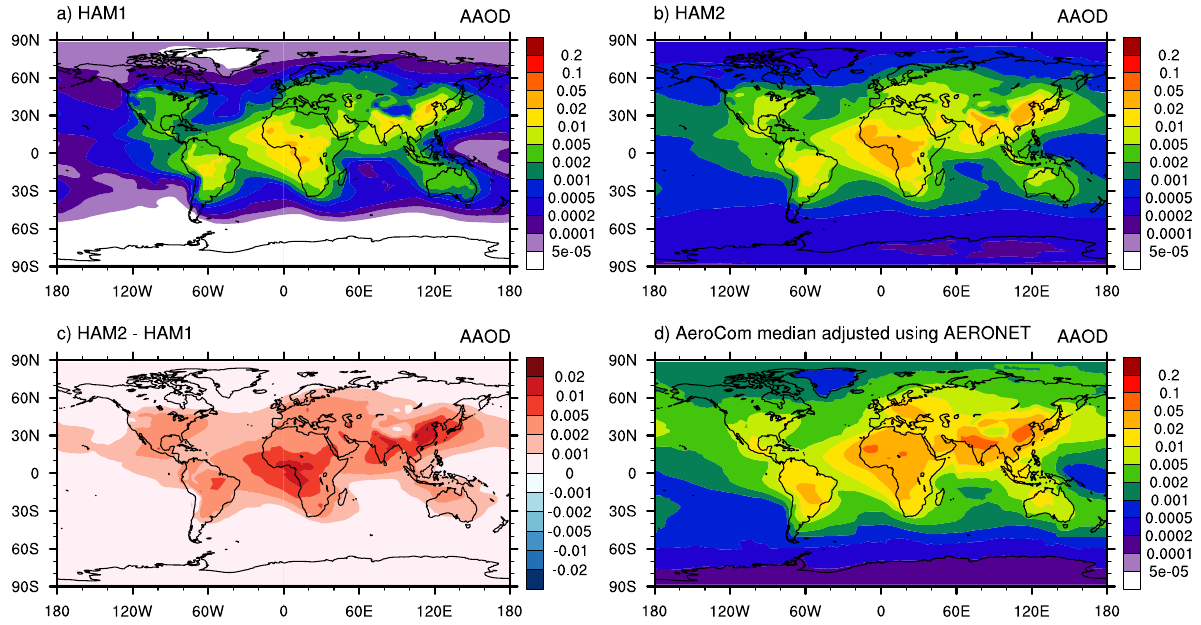
Fig. A2. Geographical distribution of the annual mean aerosol absorption optical depth (AAOD) simulated by HAM1 and HAM2 (top row), their differences (bottom left panel), and the reference result (bottom right panel) compiled by Kinne et al. (2012) using the AeroCom multi-model median adjusted with AERONET measurements.